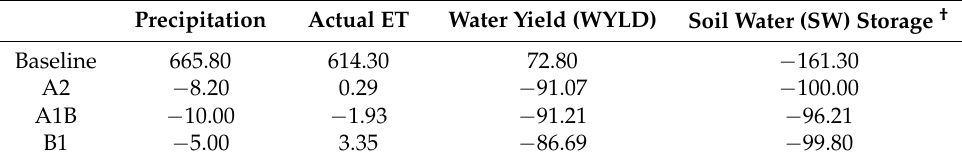
Table 3. Water balance components observed for the baseline and relative changes noticed in percentage for different climate change